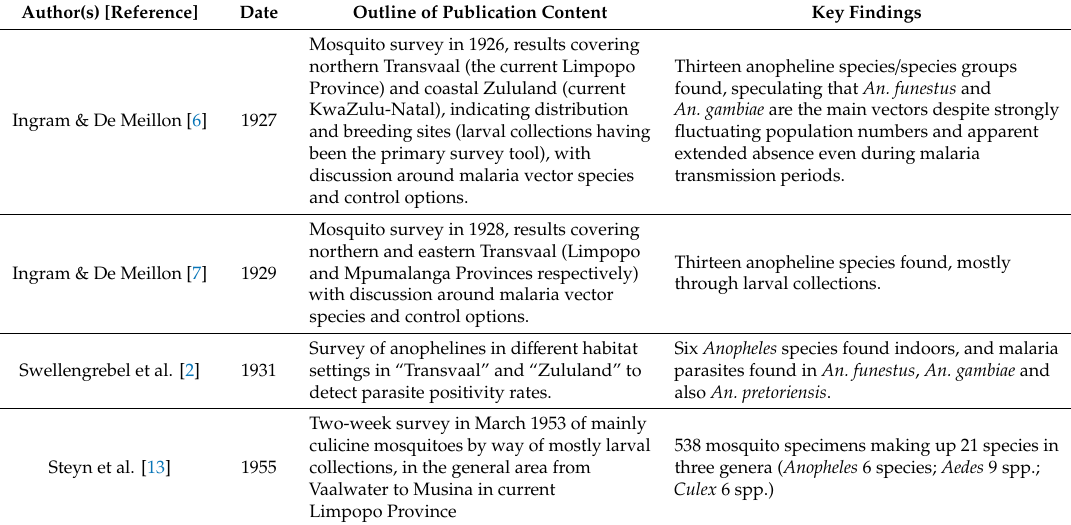
Table 1. Summary of key publications providing data on vectors for Limpopo Province, South Africa, and immediate neighboring regions.